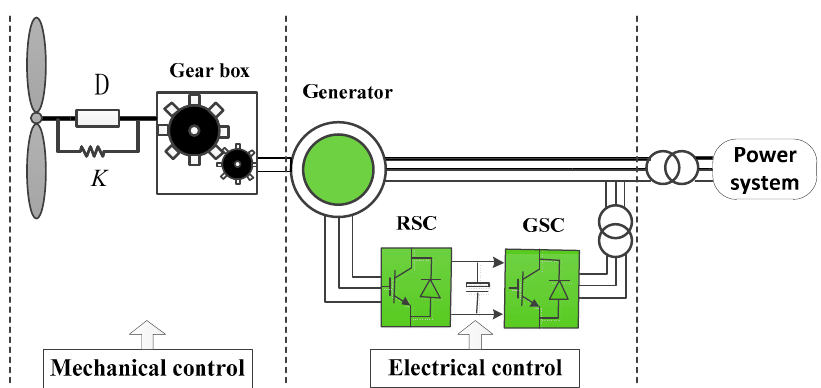
Figure 1. Doubly-fed induction generator (DFIG) wind turbine model and its control systems.